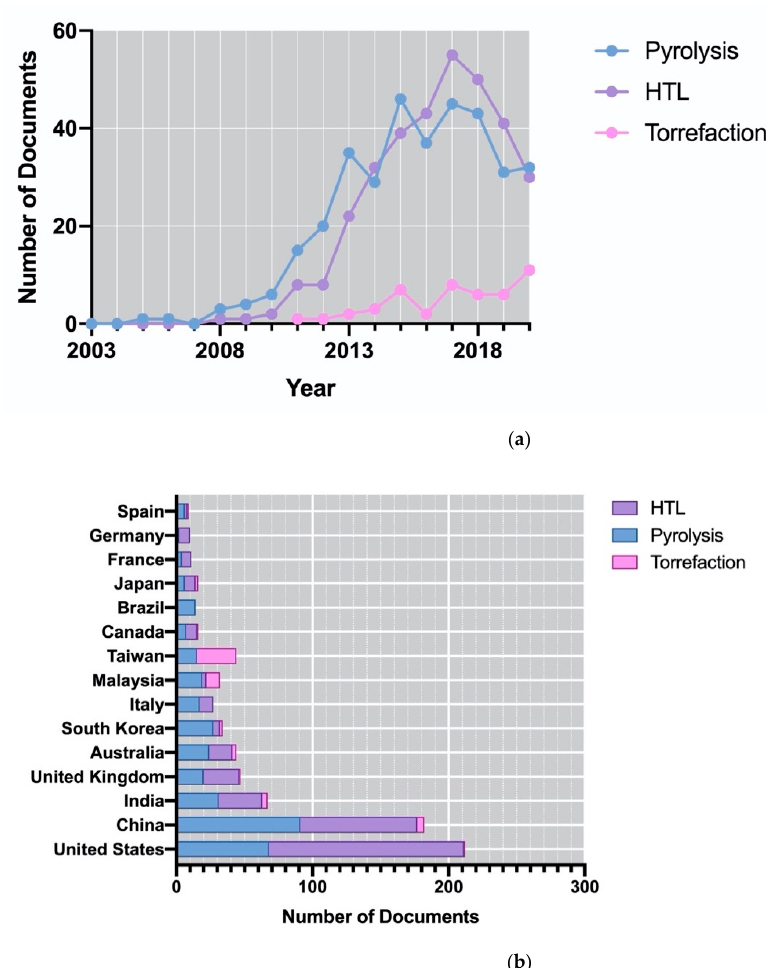
Figure 3. Evolution of the number of publications from 2003 to 2020 on torrefaction, pyrolysis and Hydrothermal Lique- faction (HTL) using algal biomass ( a ) and their country of origin ( b ).